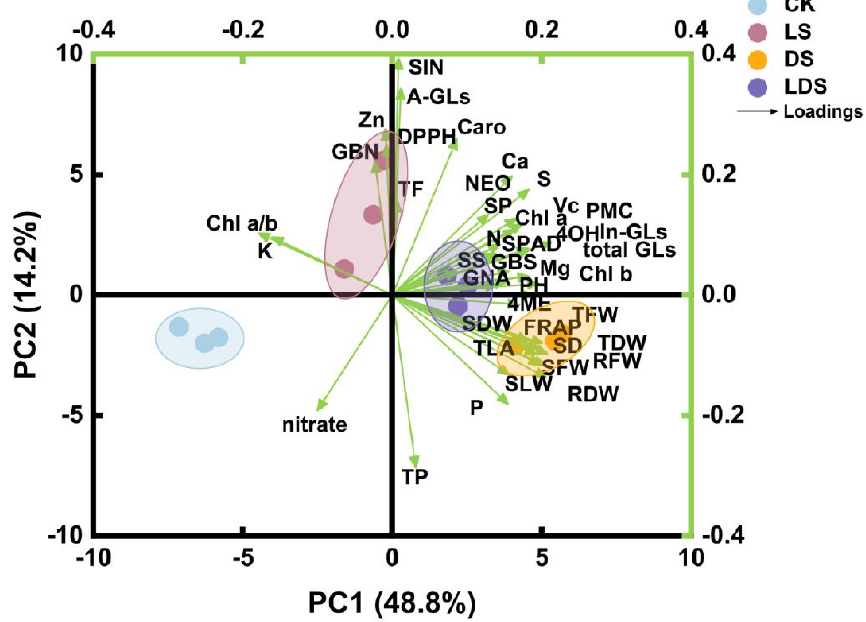
Figure 3. The multivariate principal component analysis presented the relationship between indexes among 4 treatments. The full name has been described in Figure 2. “LS” = Light-UVA Supplementation, “DS” = Dark-UVA Supplementation, “LDS” = Light/Dark-UVA Supplementation.